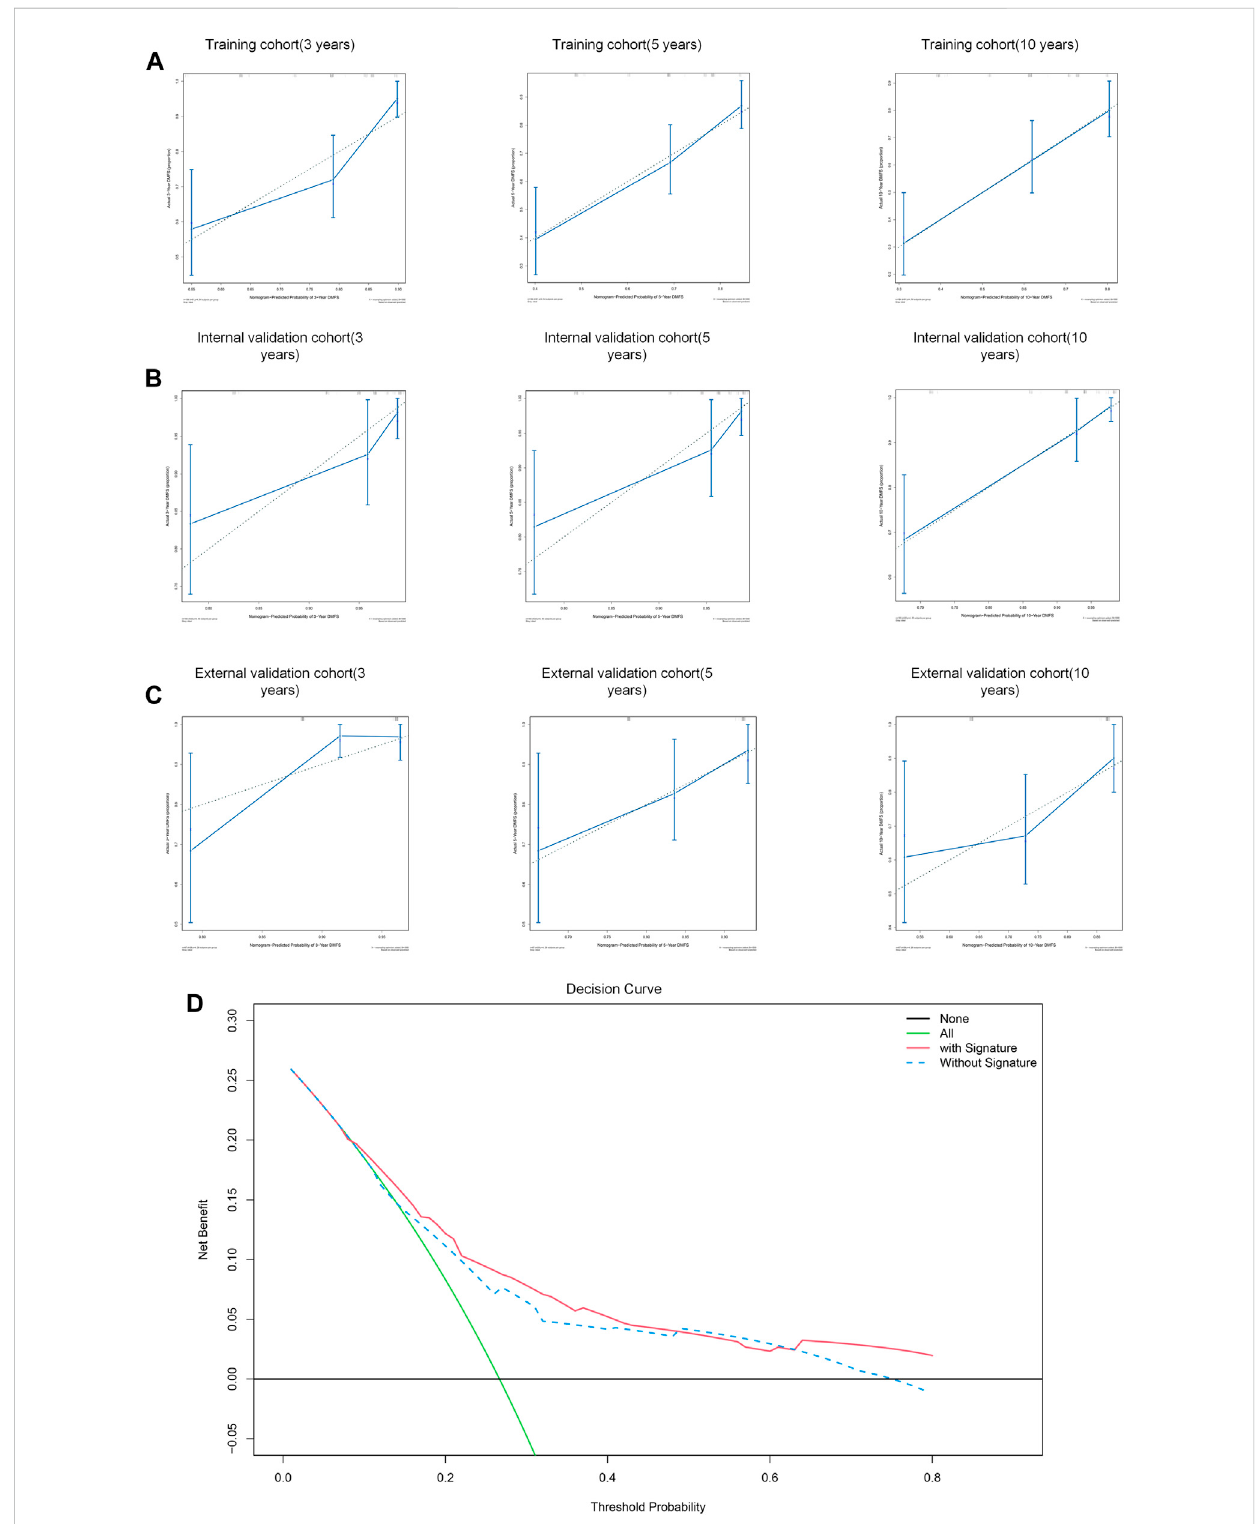
FIGURE 10 Performance of the nomogram to predict DMFS. (A – C) Calibration curves of 3-year, 5-year and 10-year DMFS in training cohort (A) , internal validation cohort (B) , and external validation cohort (C) . (D) Decision curve analysis for the nomogram with/without